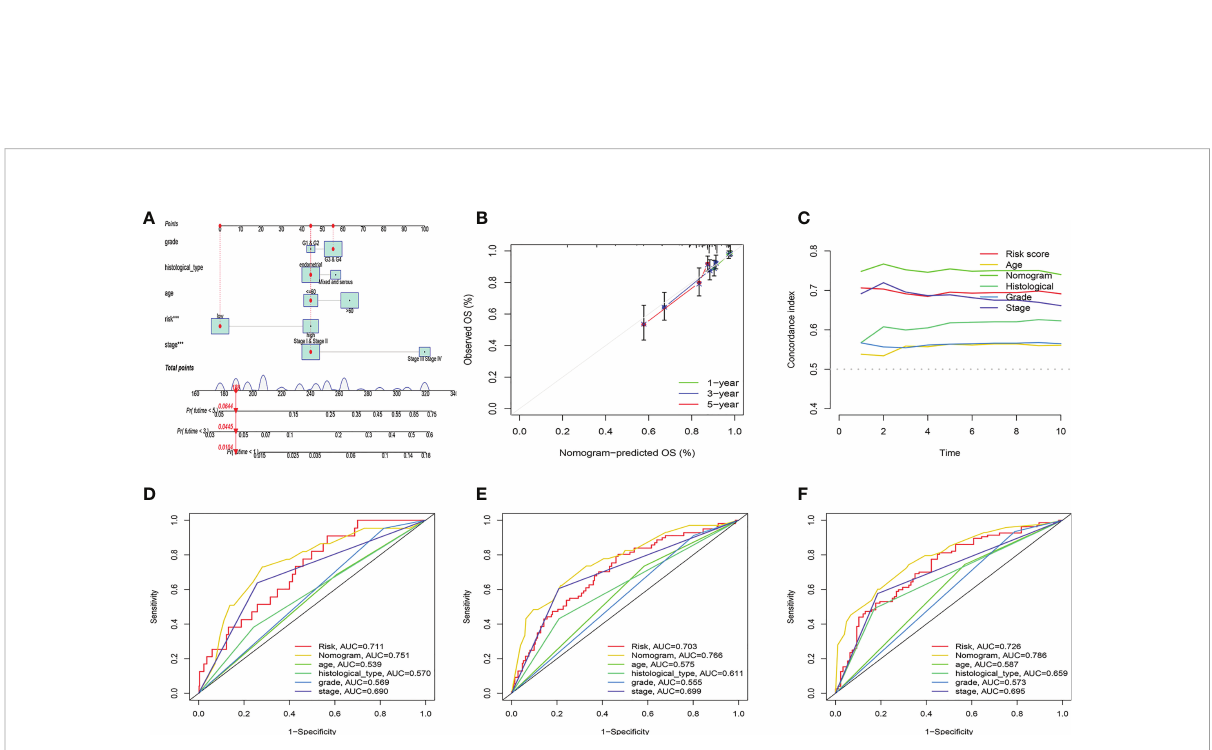
FIGURE 9 Nomogram construction and evaluation. (A) According to the nomogram, the 1-, 3-, and 5-year mortality rates for the patients were 0.0104, 0.0445, and 0.0644, respectively. (B) Calibration curve for nomogram. (C) C-index curve. (D-F) ROC curves.